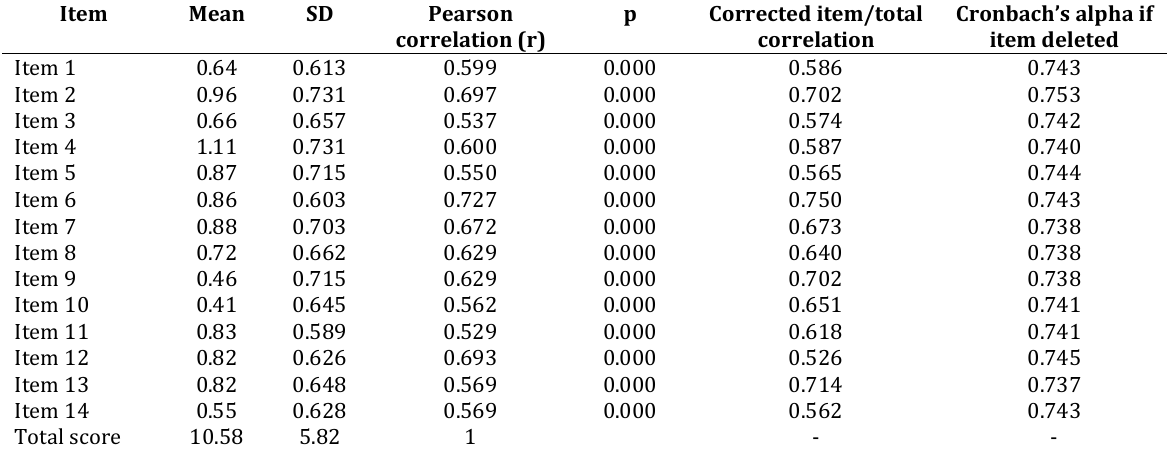
Table 3. Descriptive Characteristics and the Pearson Correlation of Each Data for Internal Consistency of Indonesian Version of the HAM-A Questionnaire